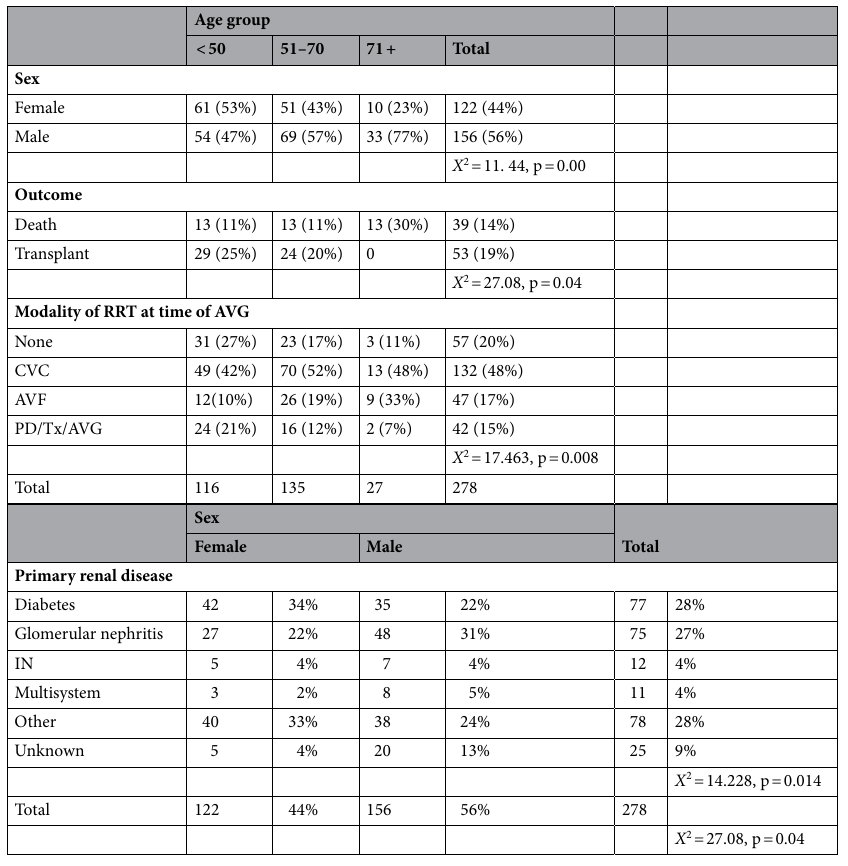
Table 2. The distribution of case-mix and outcomes by age group and